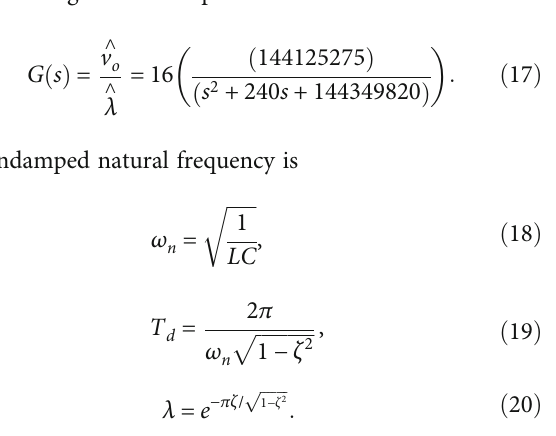
Figure 13: Simulated response of V dissimilar T d